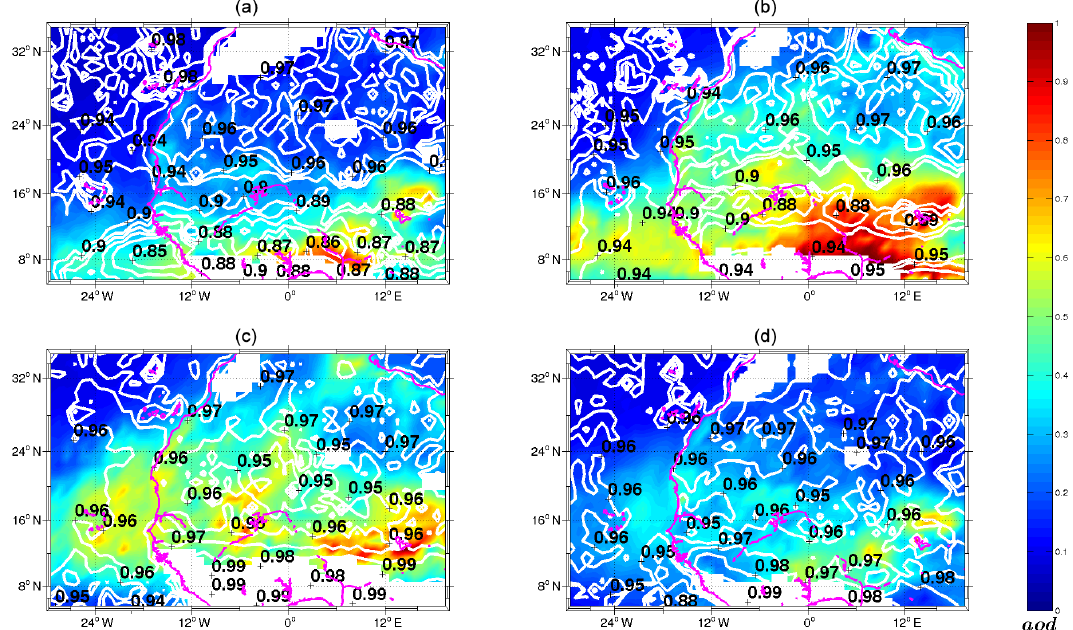
Figure 3. Seasonal distribution of aerosol optical depth (average between 2005 and 2010) at 550nm wavelength (colors) from SeaWiFS for (a) DJF; (b) MAM; (c) JJA; and (d) SON. SSA from OMI is superimposed with white contour